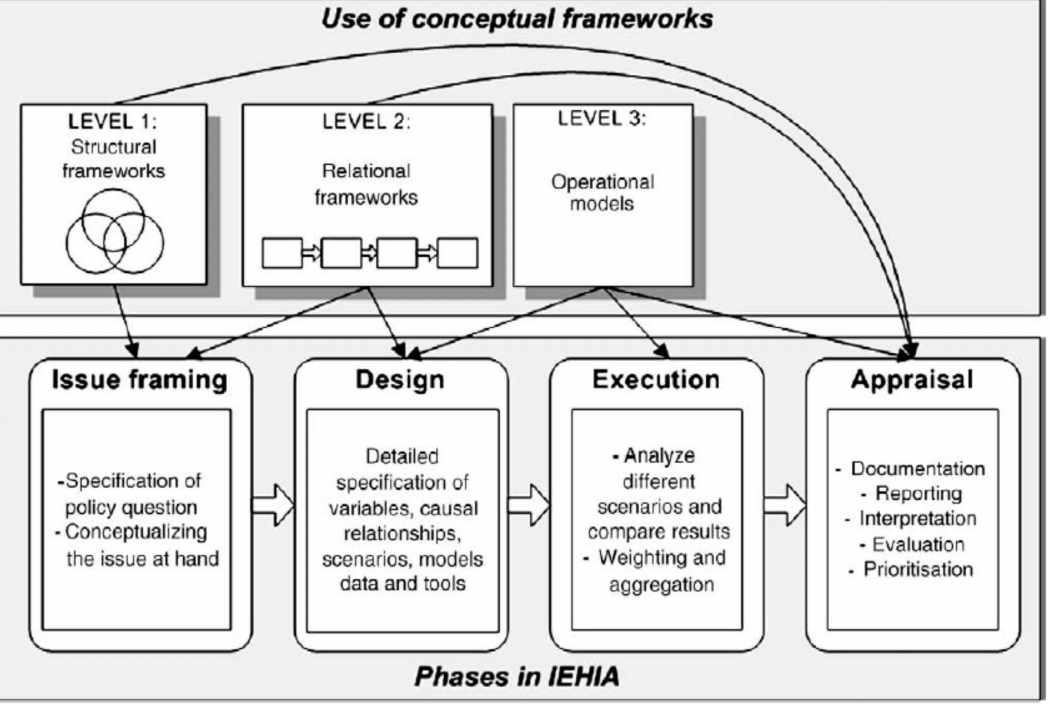
Figure 4. Phases in the process of an Integrated Environmental Health Impact Assessment and associated use of conceptual frameworks